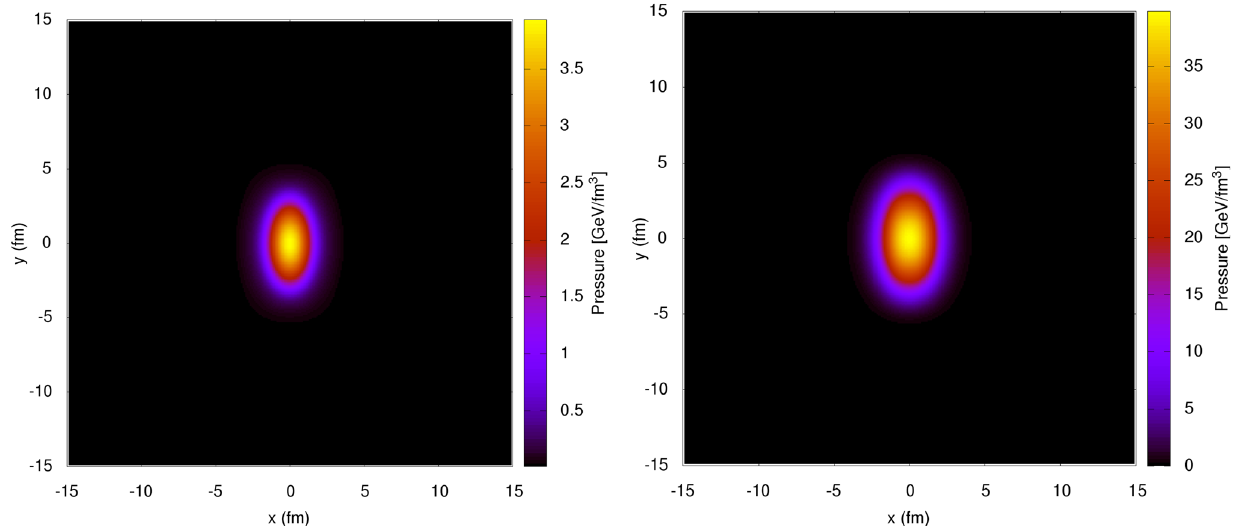
Fig. 14 Initial pressure distribution along the transverse plane at η = 0 for collisions with impact parameter b = 12fm. The left figure refers to √ s NN = 200GeV at τ 0 = 0 . 4fm/c, the right figure refers to Pb+Pb collisions at Au+Au collisions at